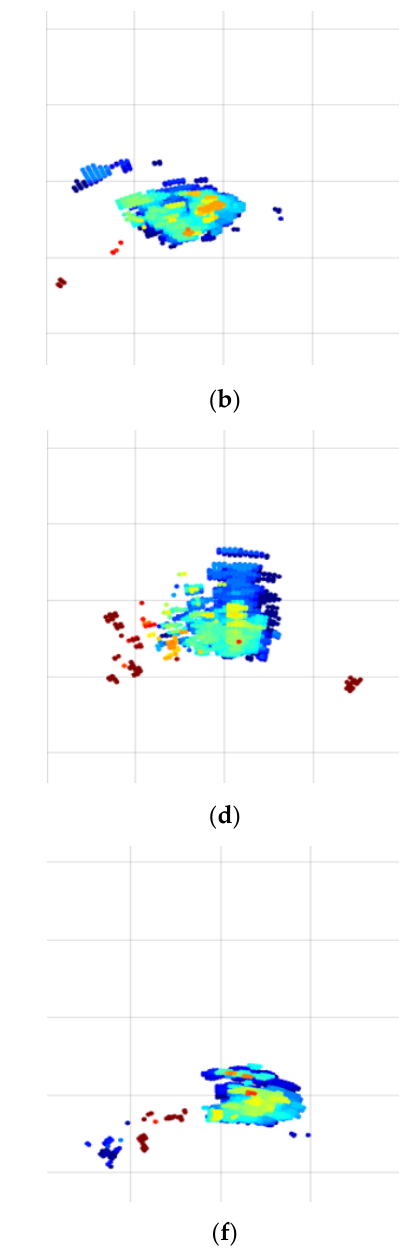
Figure 7. Range–Doppler map and point cloud map when a car moves: ( a ) range–Doppler map when moving diagonally; ( b ) point cloud map when moving diagonally; ( c ) range–Doppler map when moving vertically; ( d ) point cloud map when moving vertically; ( e ) range–Doppler map when moving horizontally; ( f ) point cloud map when moving horizontally.